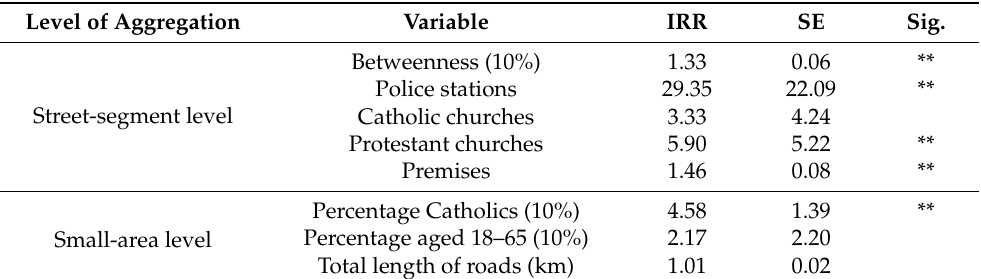
Table A3. Estimates from an OLRE Poisson regression of the location of violent dissident Republican incidents without small-area ‘totals’